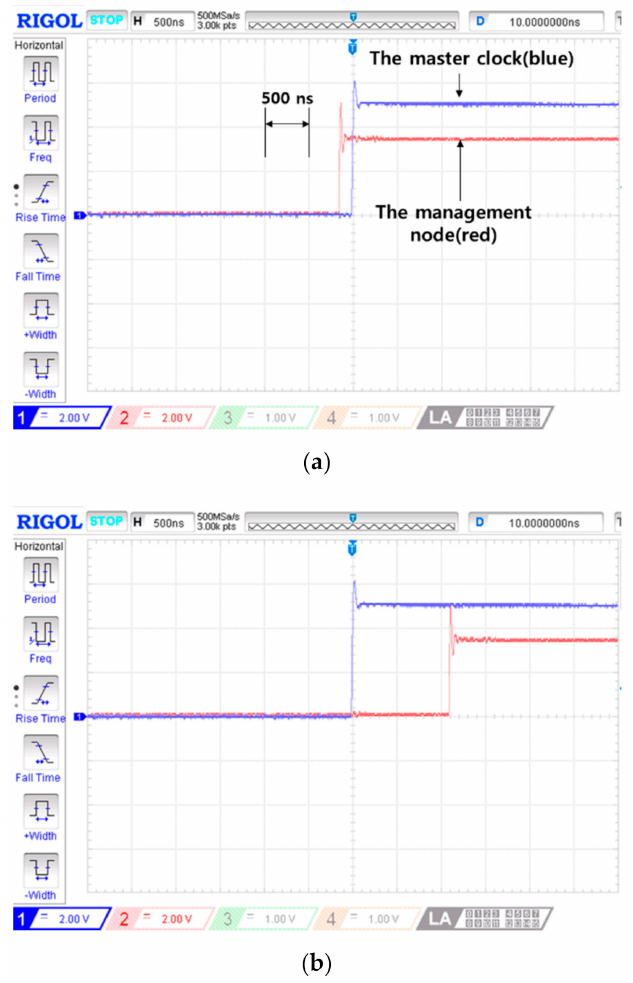
Figure 9. Operation test result of the proposed collaborative PTS sustaining algorithm. Two 1-PPS signal comparisons over time after the master failure. ( a ) 0 s (at the time of the master failure occurrence); and ( b ) 62